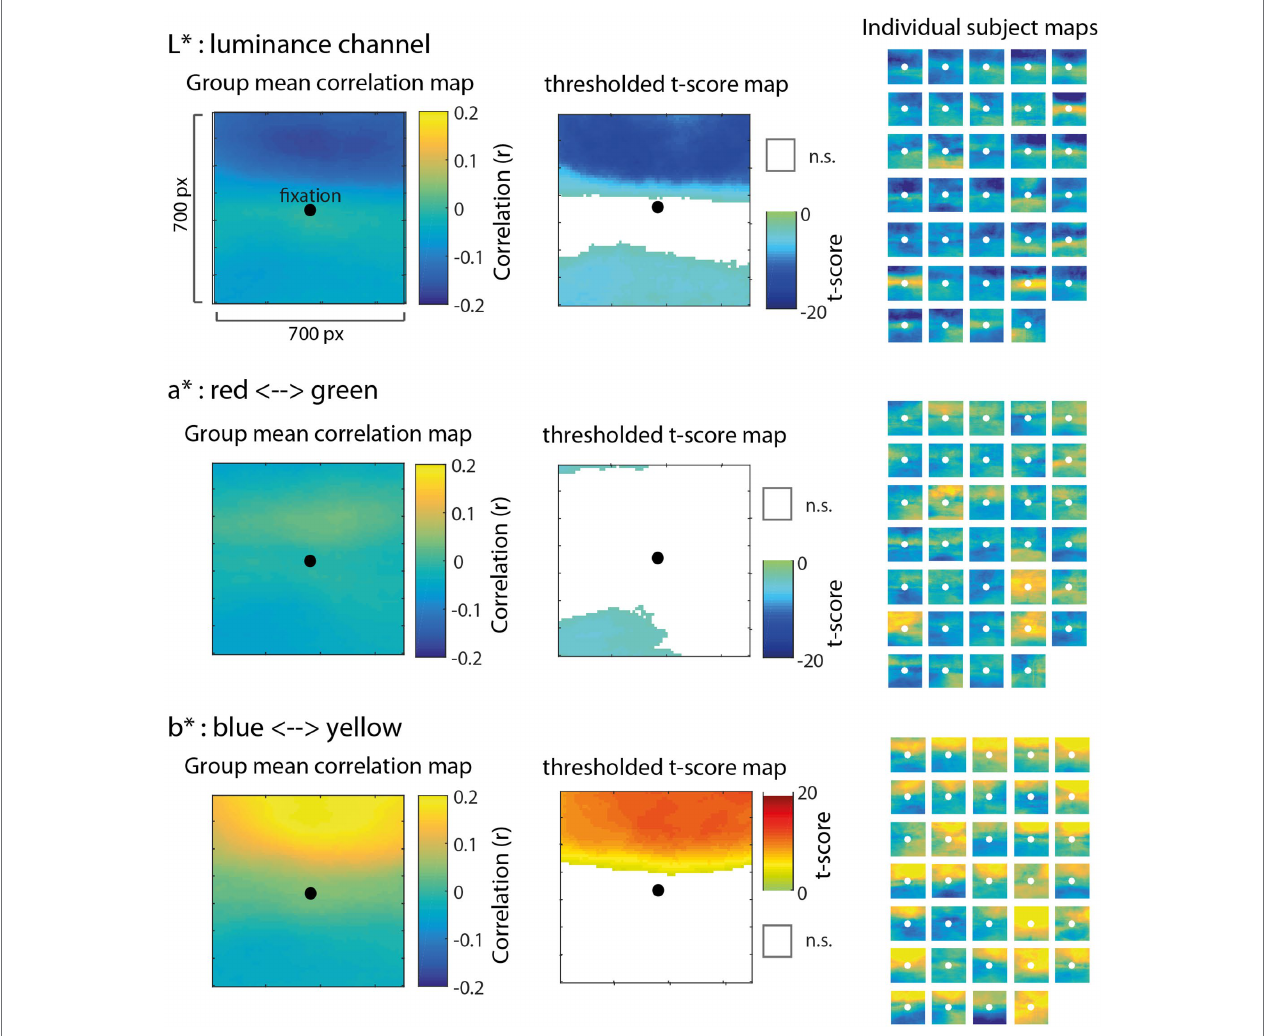
FIGURE 5 | Results of the correlation map analysis for images transformed to CIELAB space with L* (top row), a* (middle row), and b* (bottom row) channels, illustrating the correlation with pupil size of each of the three dimensions in a 700 × 700 pixel square region surrounding fixation (similar to Figure 3 ). In CIELAB space, L* represents luminance on a scale of 0–100, a* represents chromaticity along the red ( − 100) and green (+100) axis, and b* represents chromaticity along the blue ( − 100) and yellow (+100) axis. Group mean correlation maps (left) are shown with a black circle as a reference to indicate the center of gaze. We computed the t -score on Fisher Z-transformed correlation values for each pixel to derive statistical maps (center) and applied a false discovery rate threshold (FDR = 0.01) with non-significant pixels (n.s.) represented as white. The positive correlation for pixels above fixation in the b* channel (bottom) indicates that decreases in pupil size (e.g., light-induced pupillary constrictions) were strongly associated with more negative values in b* space (e.g., increases in blue chromaticity). Individual maps for each of 34 subjects (right) are shown to visually inspect the consistency of results across